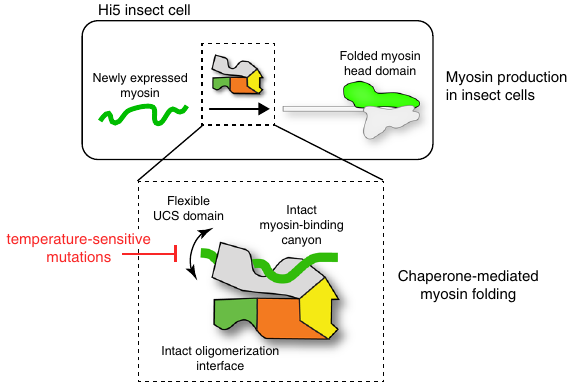
Fig. 6 UNC-45 chaperone function in folding the myosin head domain. Fully functional myosin can be obtained by co-expression with its cognate chaperone UNC-45 in insect cells. UNC-45 ’ s ability to support myosin folding strongly depends on the fl exibility of its UCS domain, the functionality of the myosin-binding canyon and its oligomerization properties. UNC-45 ts-mutations limit this conformational fl exibility and therefore interfere with myosin binding and chaperone